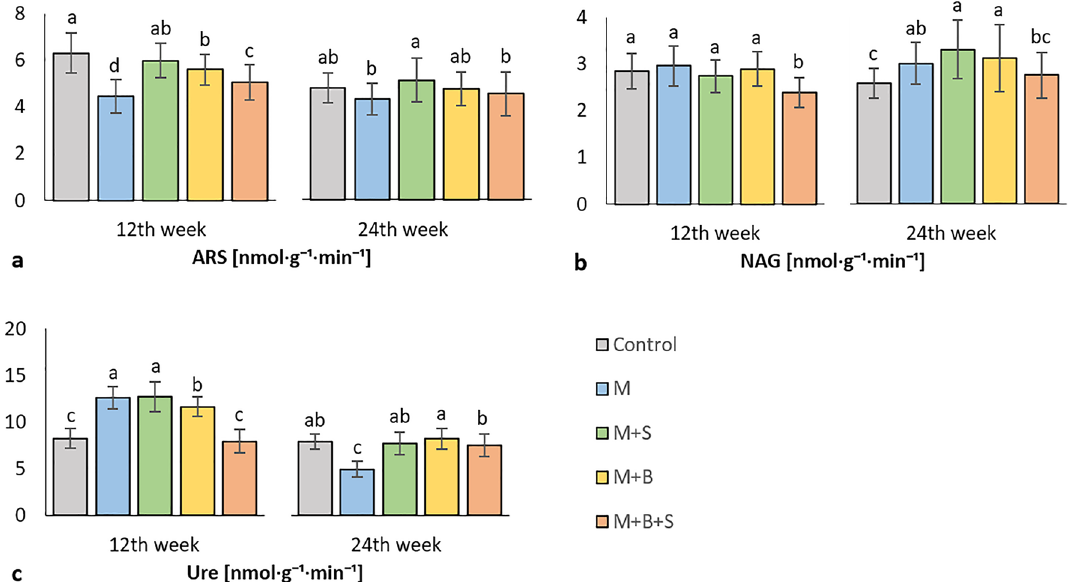
Figure 4. Soil arylsulfatase ( a ), N-acetyl-b-D-glucosaminidase ( b ), and urease ( c ) activity after 12 and 24 weeks of cultivation. Average values (n = 4) are displayed, error bars are standard error of mean. The different letters of variant values indicate a statistical difference among them at the level p ≤